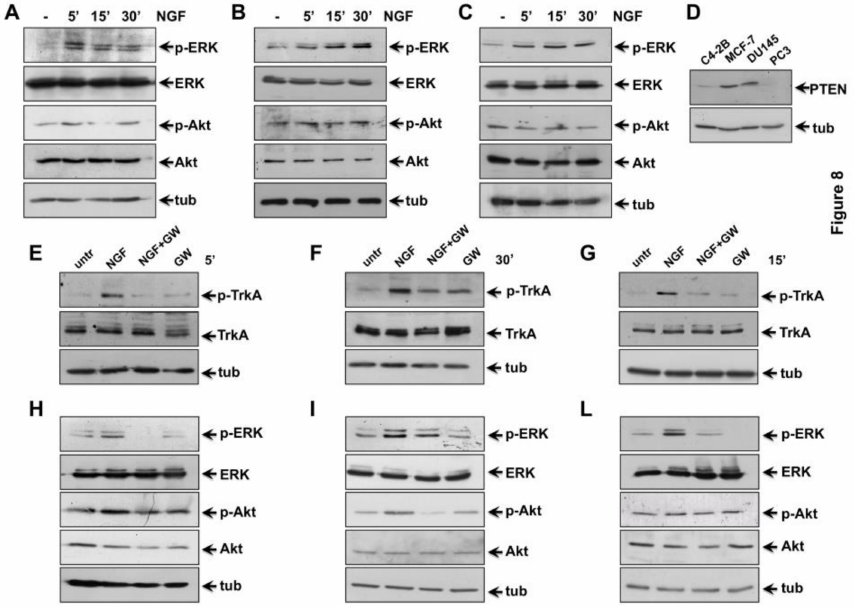
Figure 8. Tropomyosin receptor kinase A (TrkA) activation by Nerve growth factor (NGF) triggers mitogen-activated protein kinases (MAPKs) and Akt activation in castration-resistant prostate cancer (CRPC) cells. Quiescent C4-2B ( A , E and H ), DU145 ( B , F and I ) and PC3 ( C , G and L ) cells were used. In A – C , cells were left un-stimulated or stimulated for the indicated times with 100 ng / mL NGF. In D , the indicated cycling cells were used. In E – L , cells were left un-stimulated or stimulated for the indicated times with 100 ng / mL NGF, in the absence or presence of GW441756 (GW; 1 µ M). In A-C, protein lysates were analyzed by western blot, using the indicated antibodies. Filters were re-probed using anti-ERK (Extracellular signal-regulated kinase) or anti-Akt or anti-tubulin (tub) antibodies, as a loading control. In ( D ), protein lysates were analyzed by Western blot, using the indicated antibodies. In E – F , protein lysates were analyzed by western blot, using the antibodies against the indicated proteins (p-TrkA stands for P-Tyr-490 TrkA). In H – L , cells were left untreated (untr) or treated for the indicated times with NGF (100 ng / mL), in the absence or presence of 1 µ M GW441756 as reported in E – G . In A , B , C , H , I , L , p-ERK stands for P-Tyr 204 ERK 1, and the corresponding phosphorylated ERK